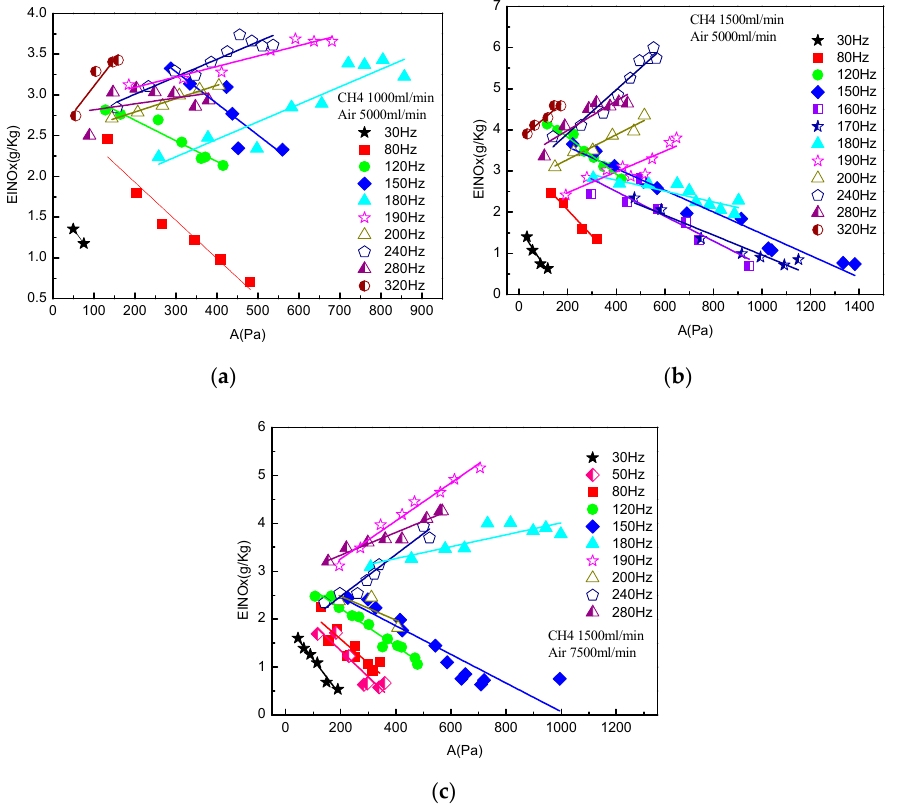
Figure 4. The relationship between acoustic parameters and NOx emission index (EINOx) for partially premixed flame; ( a ): Case 1; ( b ): Case 2; ( c ): Case 3